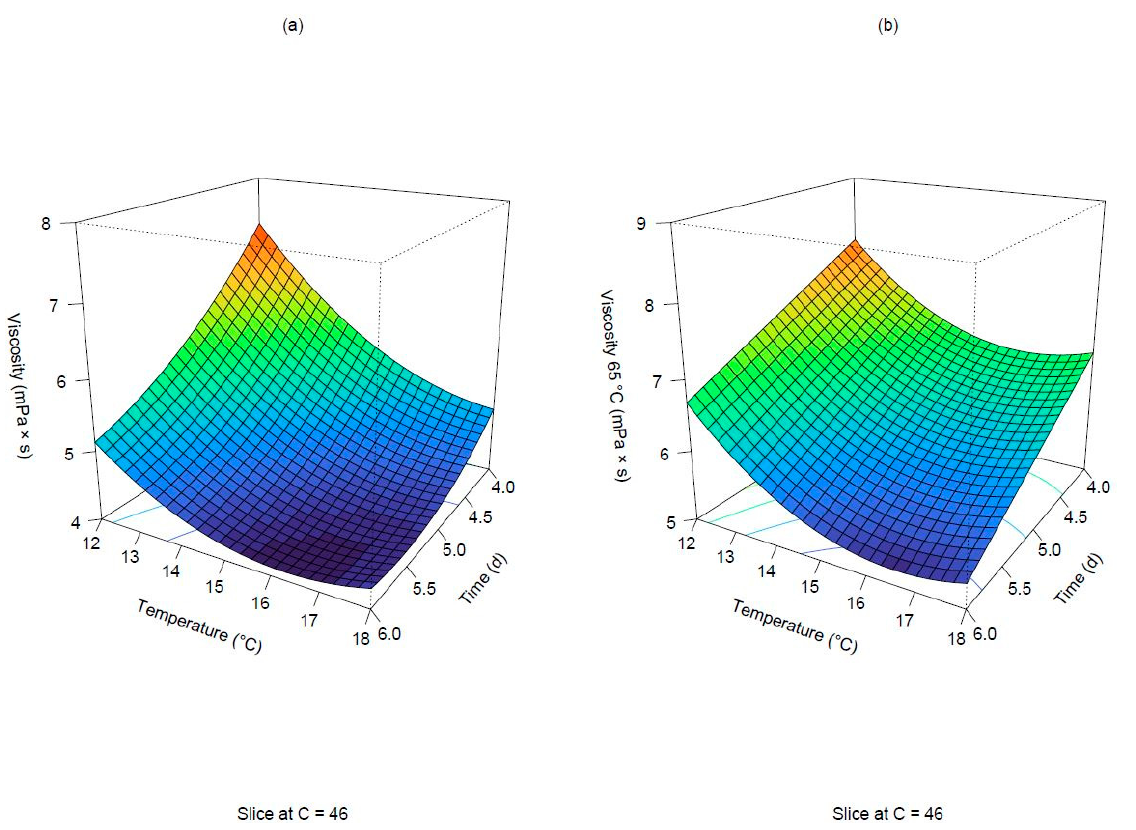
Figure 5. Surface plots of viscosities. Predicted viscosities in Congress ( a ) and isothermal mash ( b ) when the degree of steeping is held at 46 g/100 g. ( b ) when the degree of steeping is held at 46 g/100